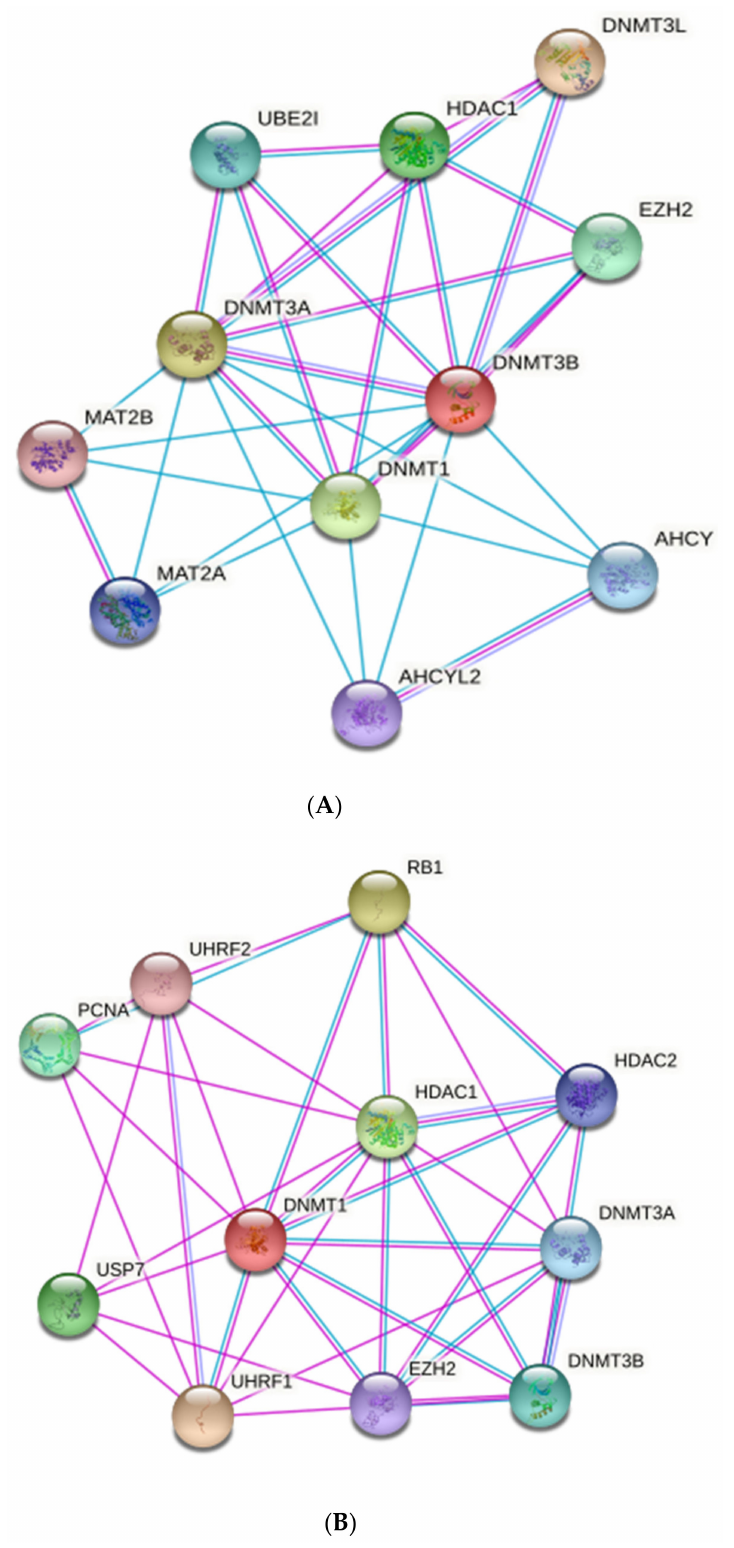
Figure 9. The interaction between DNMT3b ( A ) and DNMT1 ( B ) with other proteins. The edges indicate both functional and physical protein associations. Settings included a minimum interaction score of